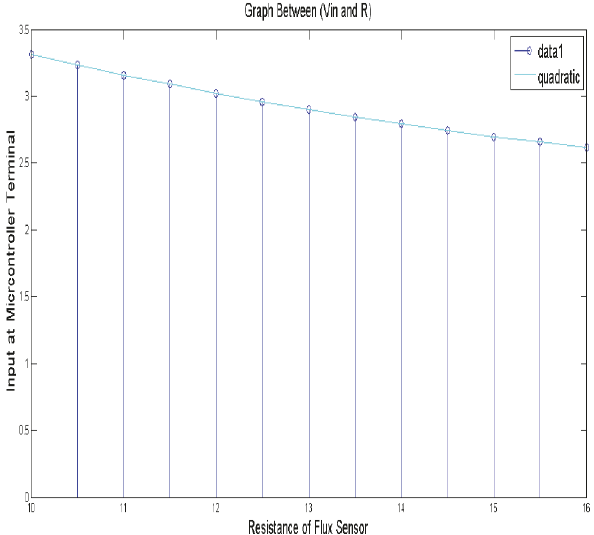
Figure 9: Input and output voltage of the controller.